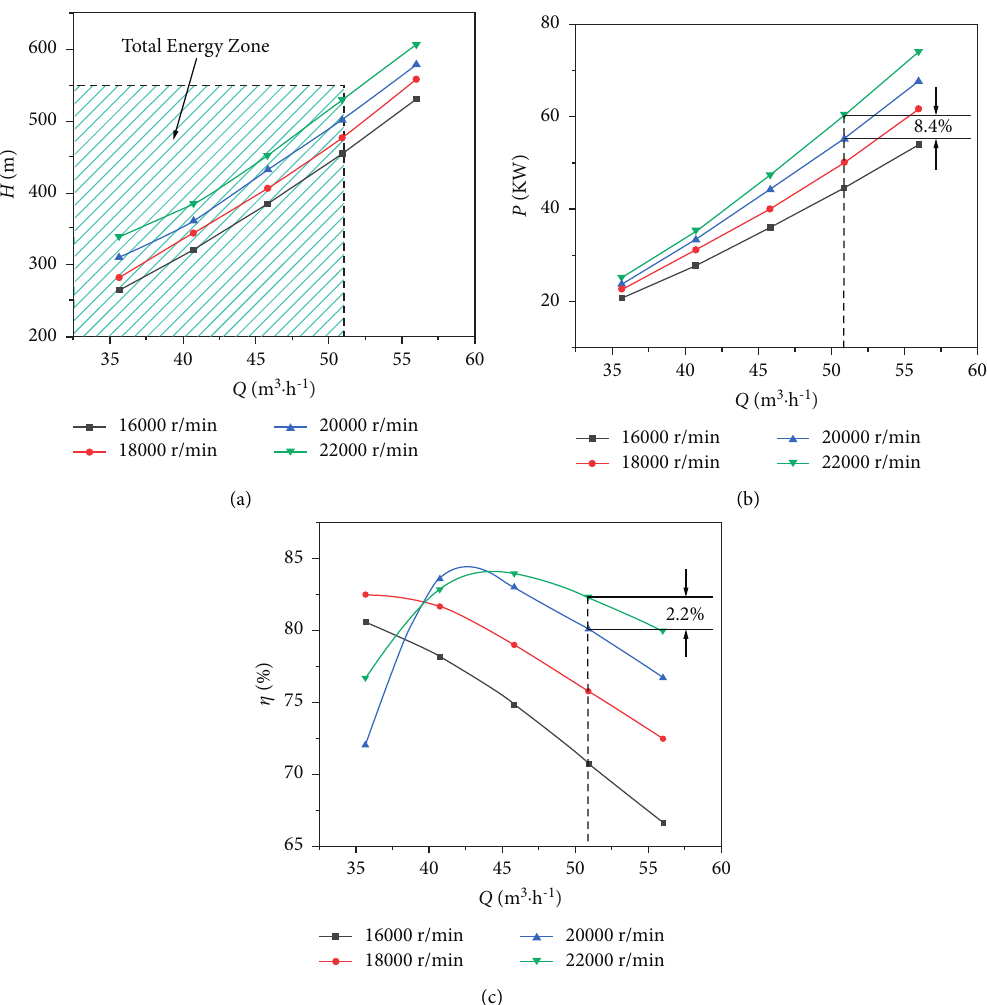
Figure 9: Performance curve. (a) Head H versus flow rate. (b) Shaft power P versus flow rate. (c) Efficiency η versus flow